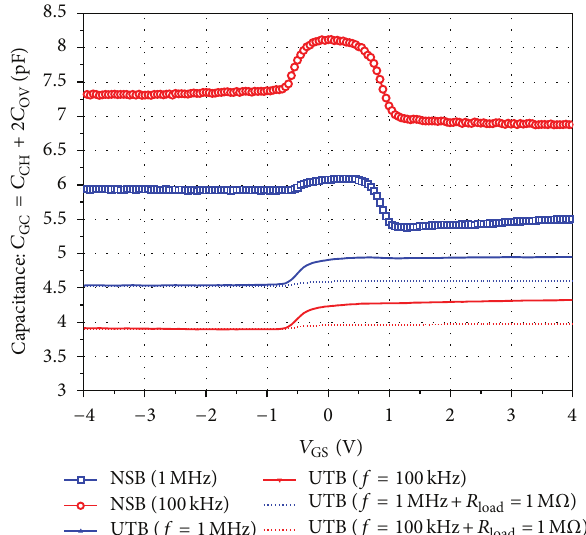
Figure 11: Representation of the gate-to-channel capacitance 𝐶 voltage for UTB and NSB devices (at 100kHz a function of the 𝑉 GS and